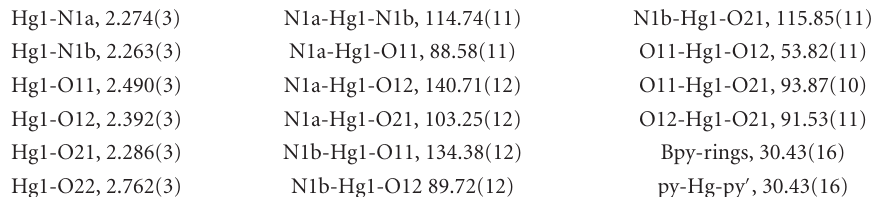
Table 3: Selected bond distances ( ˚A) and angles ( o ) for compound 2 .